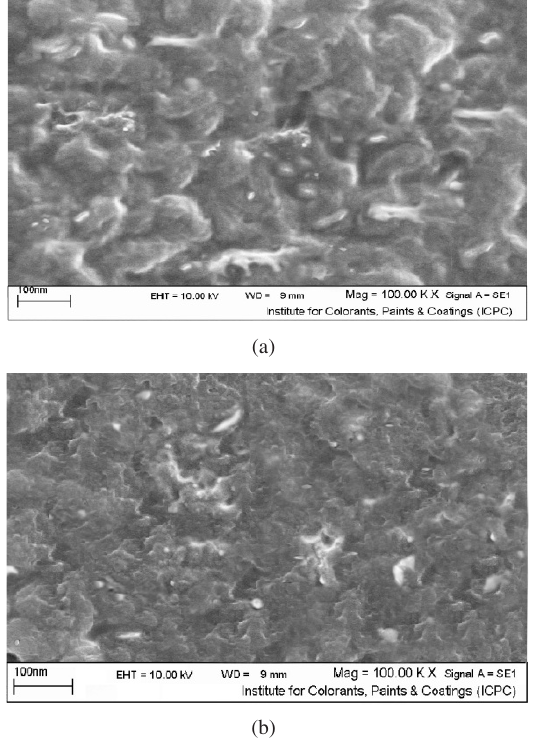
Figure 5. Scanning electron micrographs of PA- nanocomposite films 5a (a) and 5b.